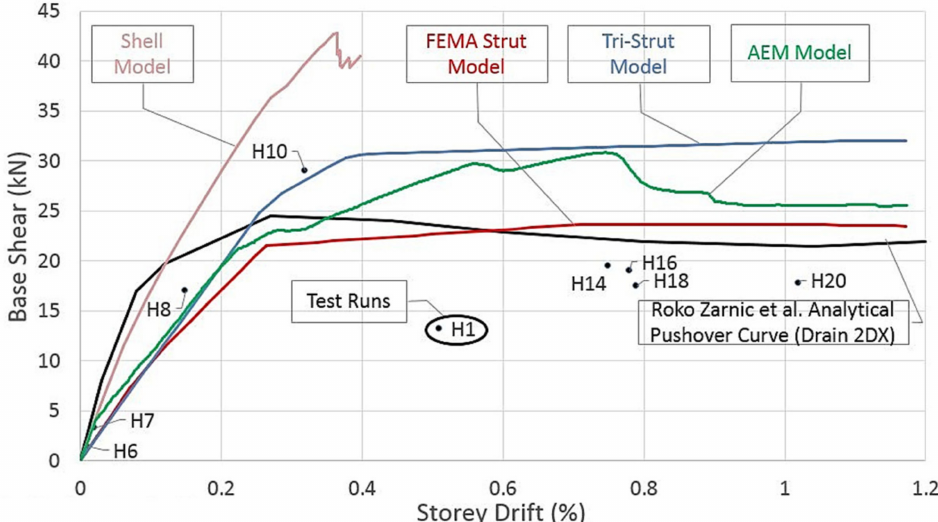
Figure 13. Comparison of predicted and experimentally obtained base shear vs story drift of scaled H-Building by Žarni´c et al. (2001) [24] and the studied analytical models. FEMA-365 [56] set three performance points (i.e., IO, LS, and CP) between the charac- teristic points B and C. IO is the abbreviation for “Immediate Occupancy”, which means that structure is in the serviceability limit state. LD is the abbreviation for “Life Safety”, which means that the structure is close to the safety limit state. CP is the abbreviation for “Collapse Prevention”, which means that the structure is close to the collapse limit